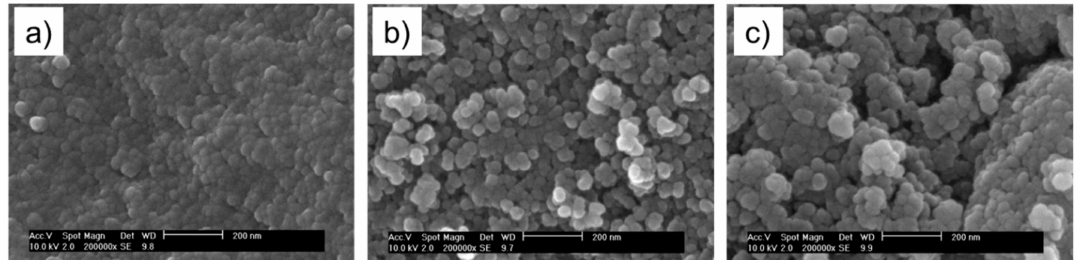
Figure 2. SEM images of: ( a ) silica, ( b ) silanised silica, and ( c ) grafted silica nanoparticles.